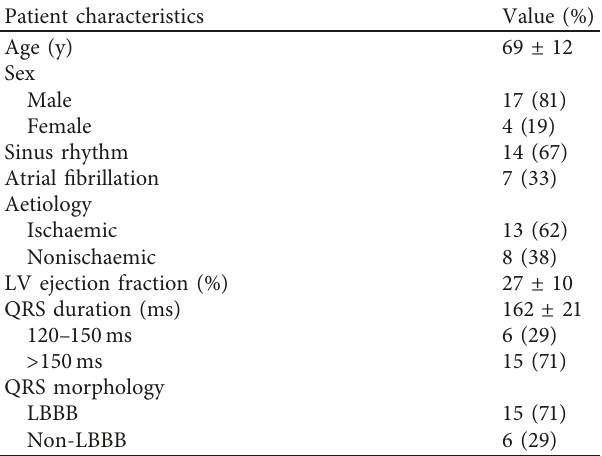
Values represent means ± SD, with percentages in parentheses where relevant. LBBB,left bundle branch block;LV, left ventricle; non-LBBB, non- left bundle branch block; RV, right ventricle.